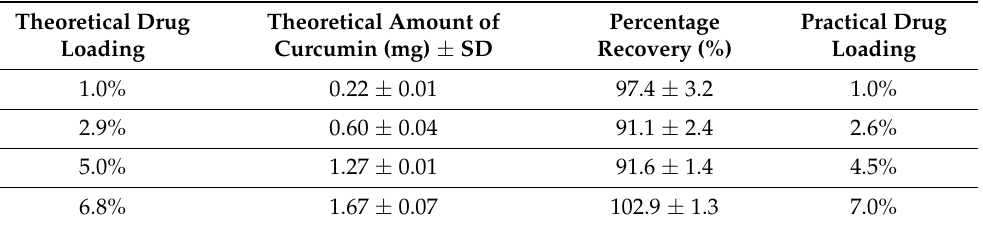
Table 5. Theoretical and practical amounts, percentage recovery of curcumin in different loading scaffolds ( n = 3).